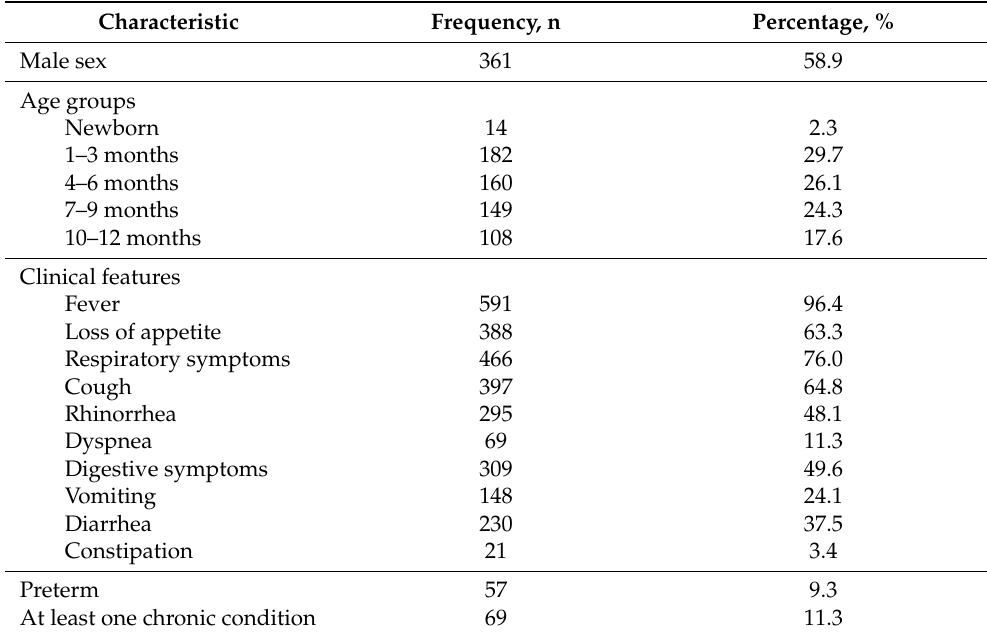
Table 1. Demographic and clinical characteristics for all infants included in the study.